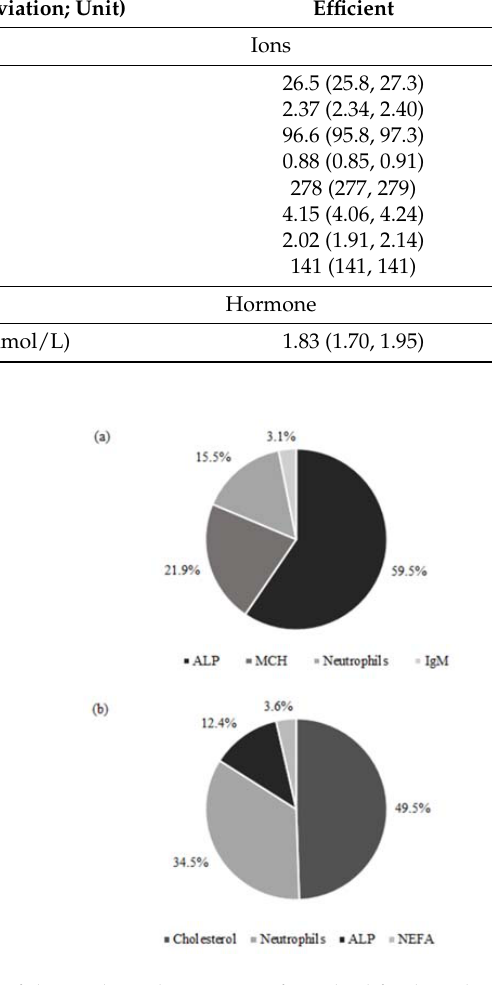
Figure 2. Contribution of the explained variation of residual feed intake by blood analytes. ( a ) heifer calves and ( b ) pregnant heifers. ALP: Alkaline phosphatase; MCH: mean cell hemoglobin. IgM: IgM secondary response; Neutrophils: segmented neutrophils and; NEFA: Non-esterified fatty acids.